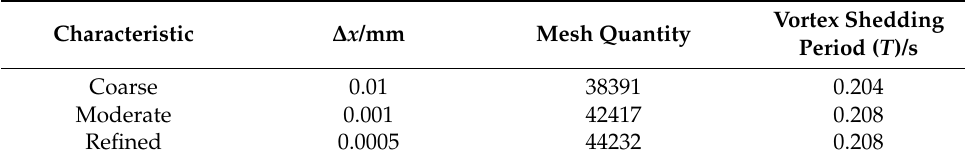
Table 2. Mesh settings of cylinder. Figure 4. Grid setup and partition: ( a ) Cylinder mesh; ( b ) NACA0012 airfoil mesh; ( c ) Mesh partition.